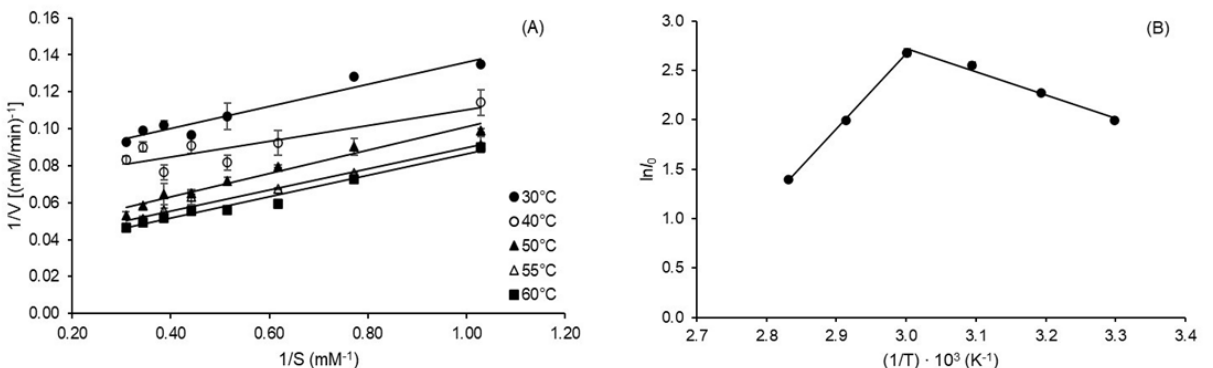
Figure 3. ( A ) Lineweaver – Burk plots for the determination of kinetic parameters of inulin hydrolysis reaction. ( B ) Arrhenius type-plot used to estimate the activation energy ( E* a ) of inulin hydrolysis catalyzed by inulinase from Aspergillus terreus URM4658 and the standard enthalpy variation of the enzyme unfolding equilibrium ( ∆ H ° u ). I 0 is the starting inulinase activity and T is the absolute temperature.